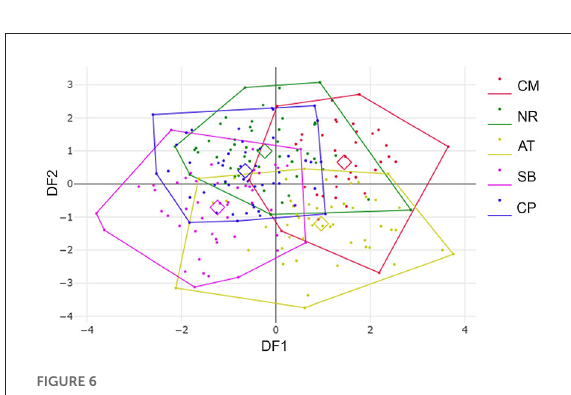
FIGURE6 Factor map based on discriminant analysis showing wing shape divergence of Tabanus rubidus among populations (CM, Chiang Mai; NR, Nakhon Ratchasima; AT, Uthai Thani; SB, Singburi; CP, Chumphon). Each point in each population polygon represents an individual specimen with the small squares representing a mean group. The horizontal axis was the first discriminant factor (DF1), while the vertical axis was the second discriminant factor (DF2).